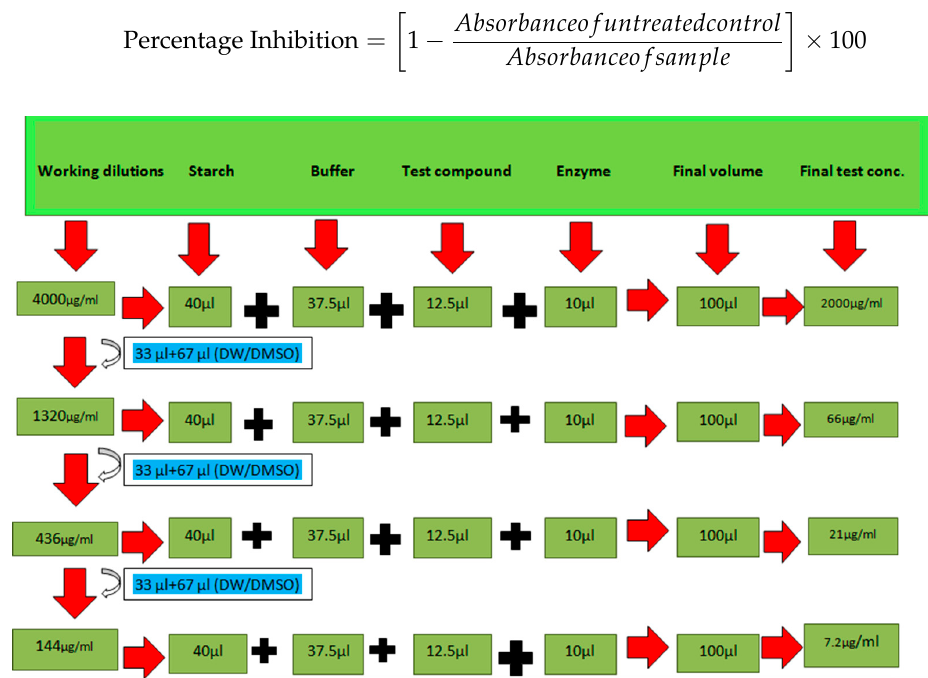
Figure 6. Pictorial description of working dilutions taken in alpha amylase inhibition assay [4,5] .